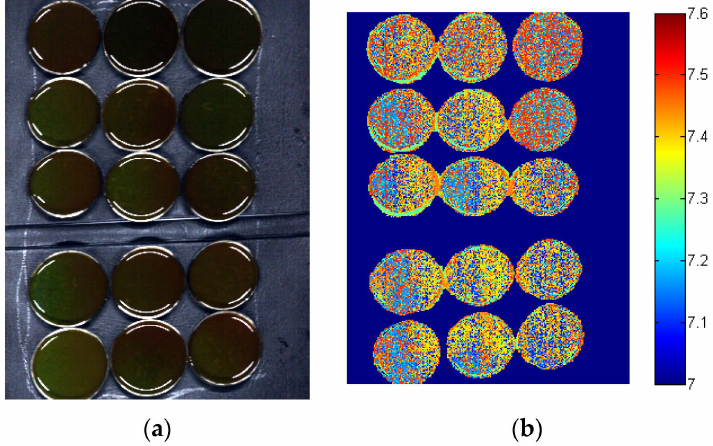
Figure 3. The pseudo color image of ( a ) a hyperspectral image and ( b ) the corresponding distribution map of pH obtained by